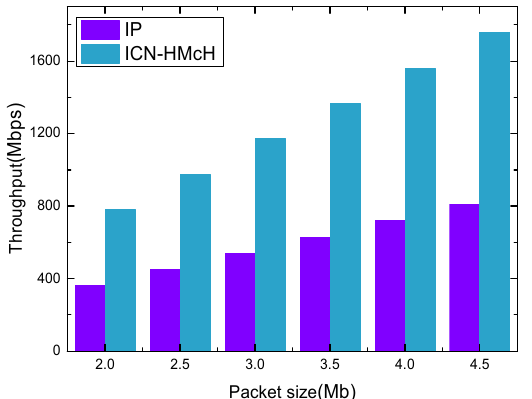
Figure 15. Throughput variation for two structured packets. (2)